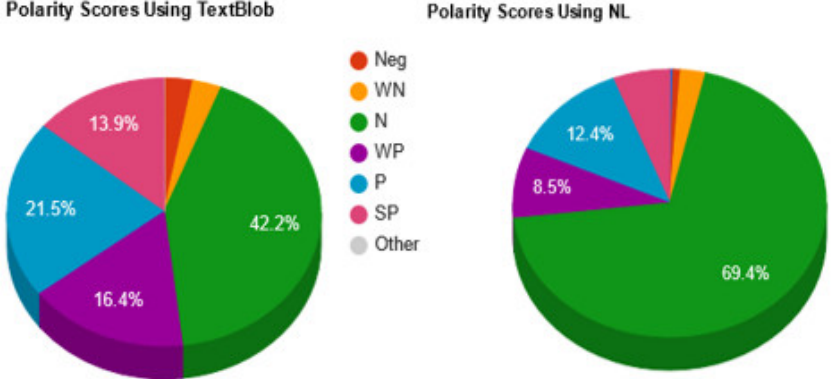
Figure 10. Polarity classes differences before and after considering user’s weight.